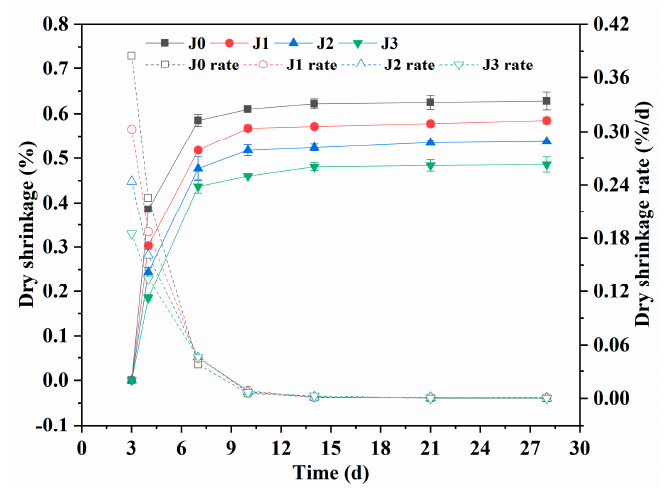
Figure 2. Dry shrinkage and shrinkage rate of M-S-H mortar with SRA.